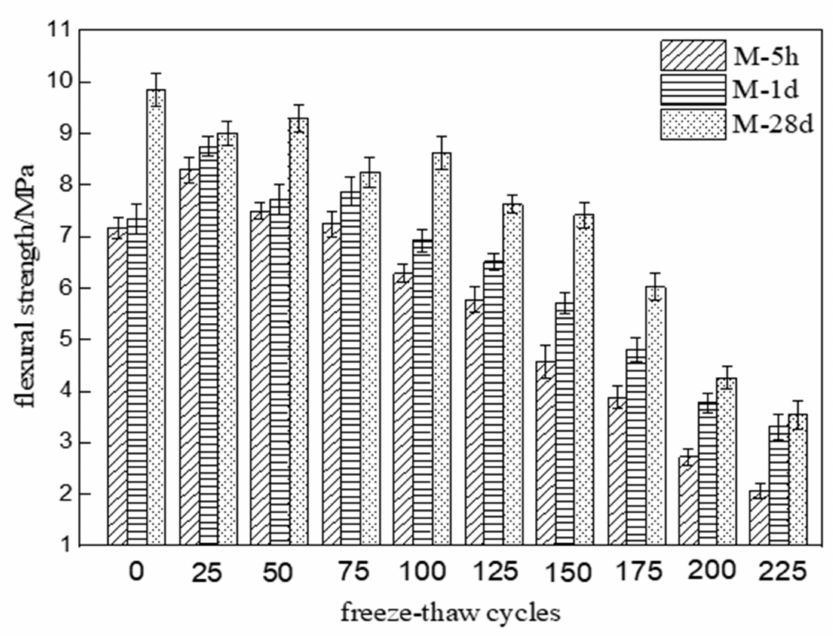
Figure 2. Flexural strength changes of MKPC mortar specimens with number of freeze–thaw cycles in 5% Na 2 SO 4 solution.